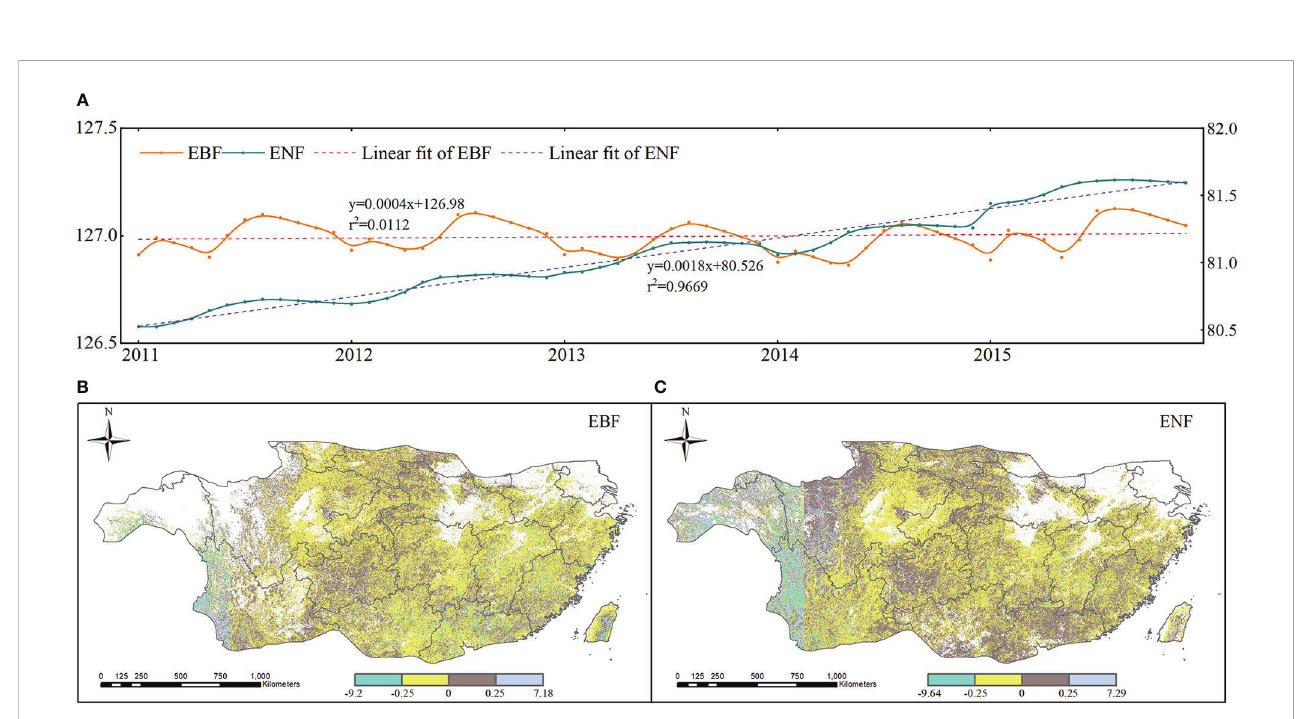
FIGURE 6 Time serials and spatial trends of carbon storage from 2011 to 2015 (A) . Monthly carbon storage; (B) trends of EBF; and (C) . trends of